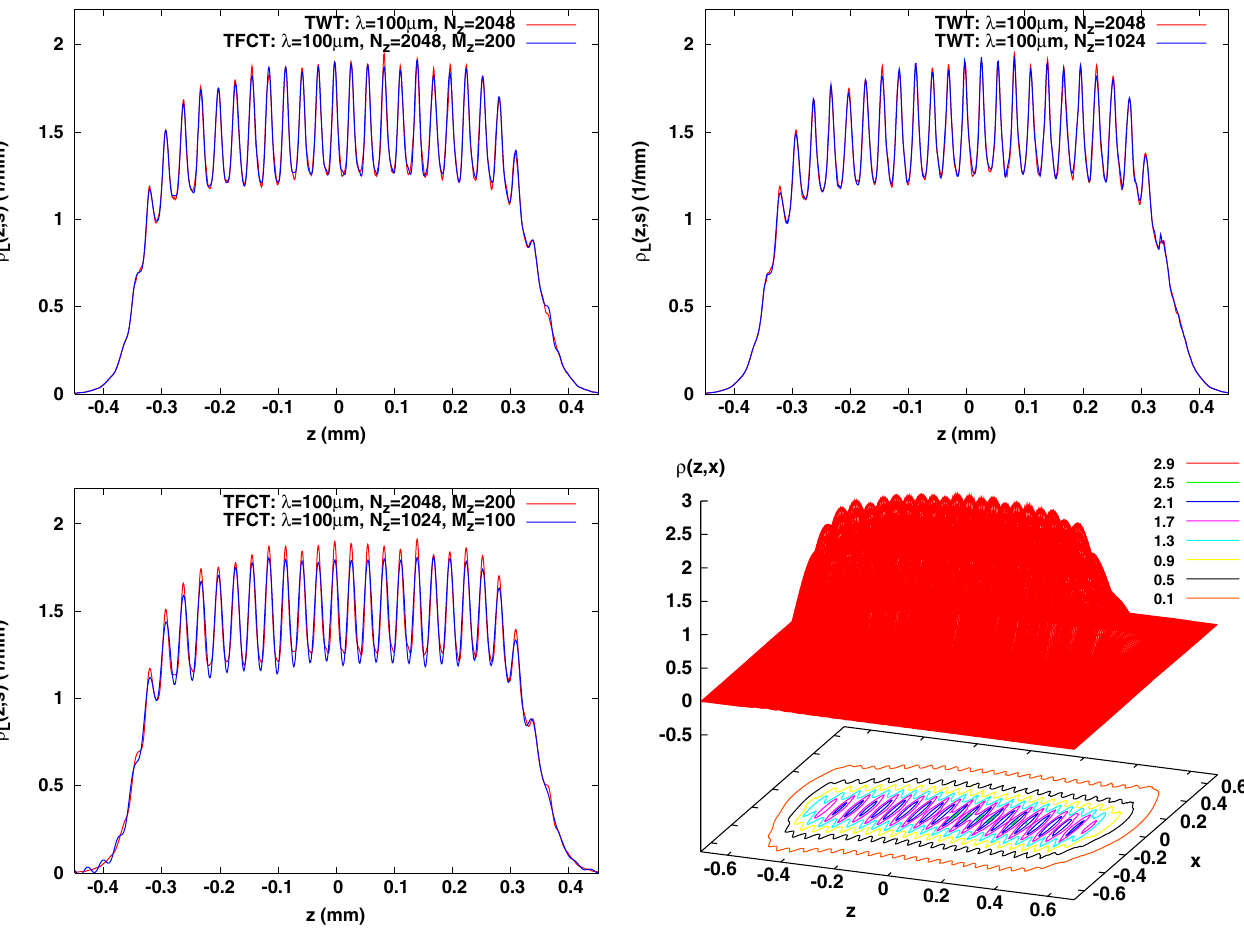
FIG. 20. Comparison of the longitudinal density at the exit of the FERMI@Elettra first bunch compressor for an initial modulation wavelength (cid:8) ¼ 100 (cid:9) m obtained with the TWT and TFCT methods. Top right: Comparison of TWT and TFCT with N ¼ 2048 and N ¼ 1024 . Bottom left: Comparison of TFCTwith N left: Comparison of TWTwith N z z right: 2D spatial density at the end of the chicane for (cid:8) ¼ 100 (cid:9) m obtained with TWT. The results are obtained in accordance to ¼ 2048 gives the same accuracy of TWT with N Table III. It is clear that TFCT with N z efficient than TFCT in its ability to resolve small-scale